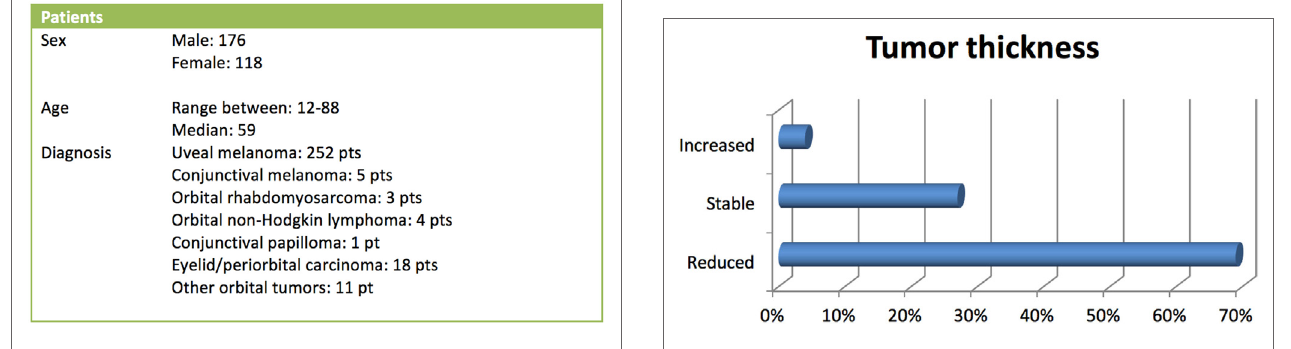
FIgURe 10 | Local control response by tumor thickness.